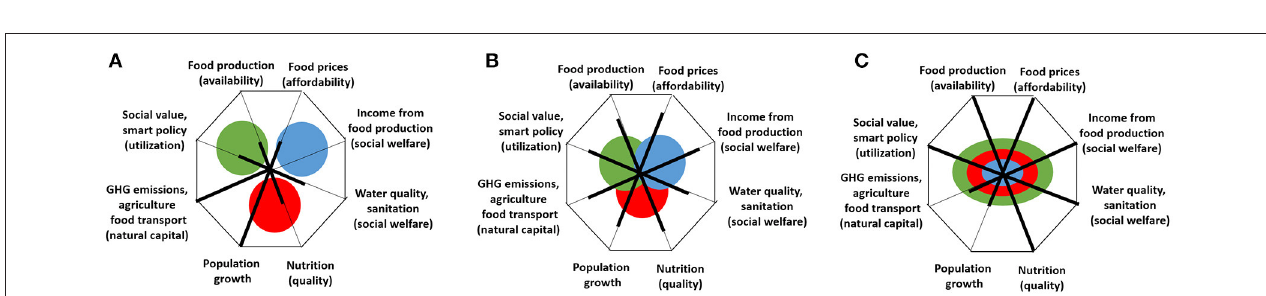
FIGURE 3 | Schematic that depicts the flow and connectivity between review of existing conceptual models from literature, what’s trending agriculturally and those developed in this study (spider, causal chain/loop, spatial/temporal scale diagrams) that were used in developing the conceptual model. Methodology followed in the study ( Figure 2 ) is elaborated here.